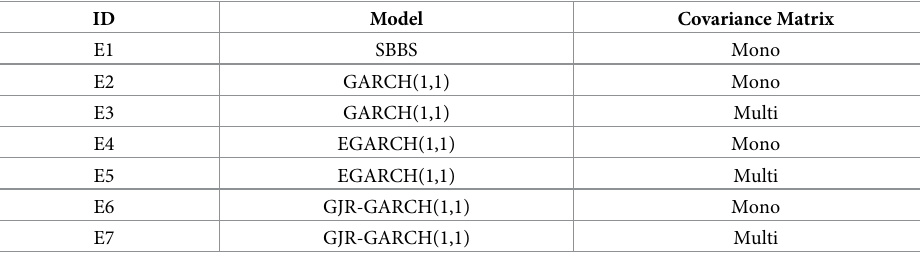
Table 4. Experiments for the multiperiod